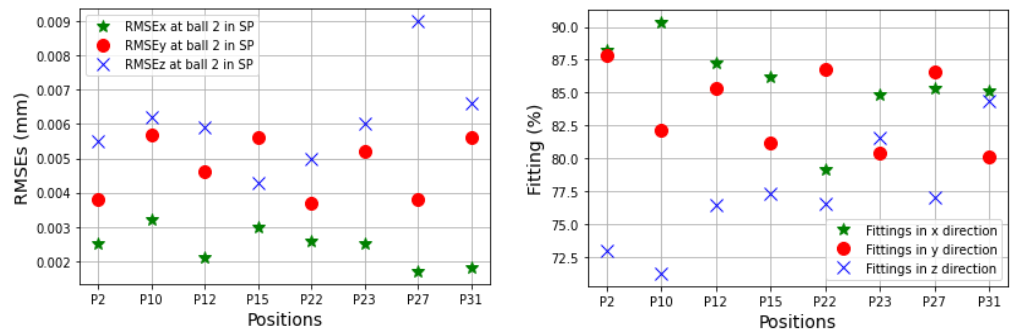
Figure 22. RMSEs and fi tt ings of eight positions at ball 2 in the short process (SP).